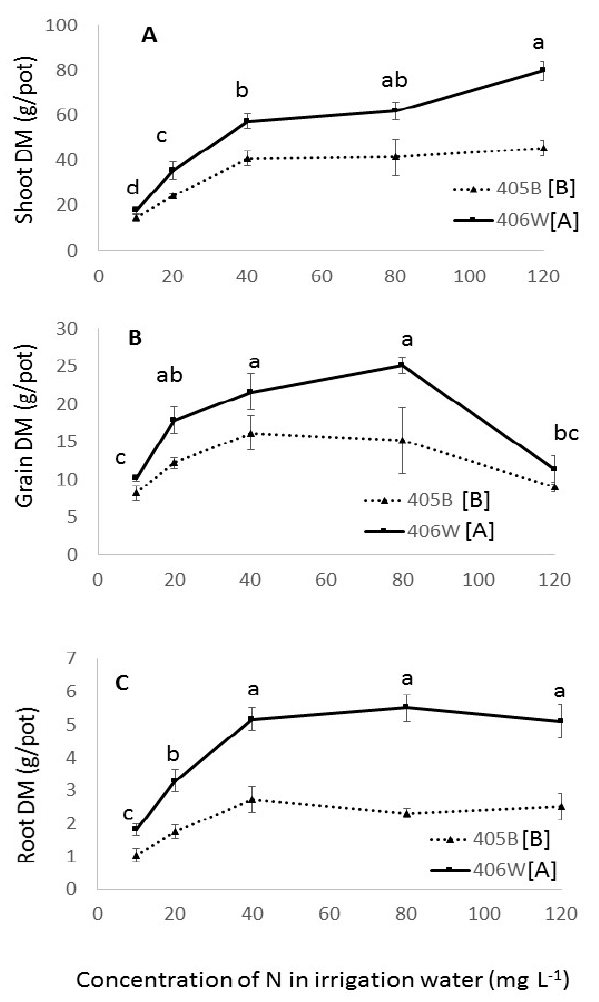
Figure 3. Shoot ( A ), grain ( B ) and root ( C ) dry matter in the winter pot experiment by N fertigation level. Dashed line represents the 405B genotype, and solid line represents the 406W genotype. Different letters represent significant (<0.05) differences for both main effects. Lower case letters adjacent to the trend line represent the results of the Tukey’s test for N concentration averaging both genotypes, and capital letters adjacent to the legend represent the results of the Student’s t -test for the two different genotypes.